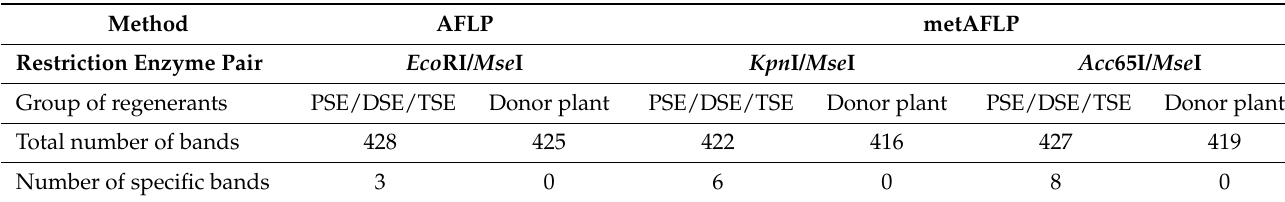
Table 4. Number of specific bands identified in the electrophoretic profiles between three sets of Polyscias filicifolia regenerants and the donor plant using three restriction enzyme pairs.